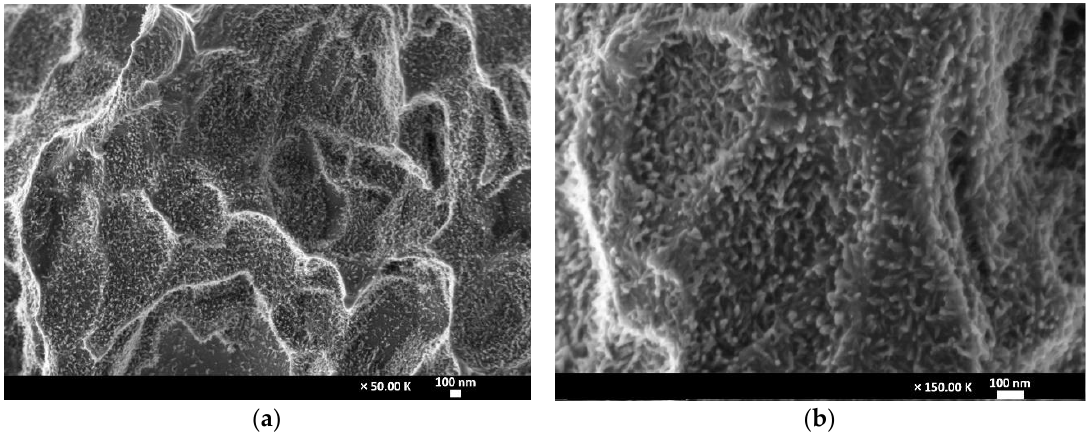
Figure 5. High resolution SEM micrographs of the implant surface. ( a ) Micrograph taken at 50k×. Note the dense package of the nanostructure all over the implant surface; ( b ) micrograph taken at 150k×. Note the finger-like nanostructures densely covering the surface.